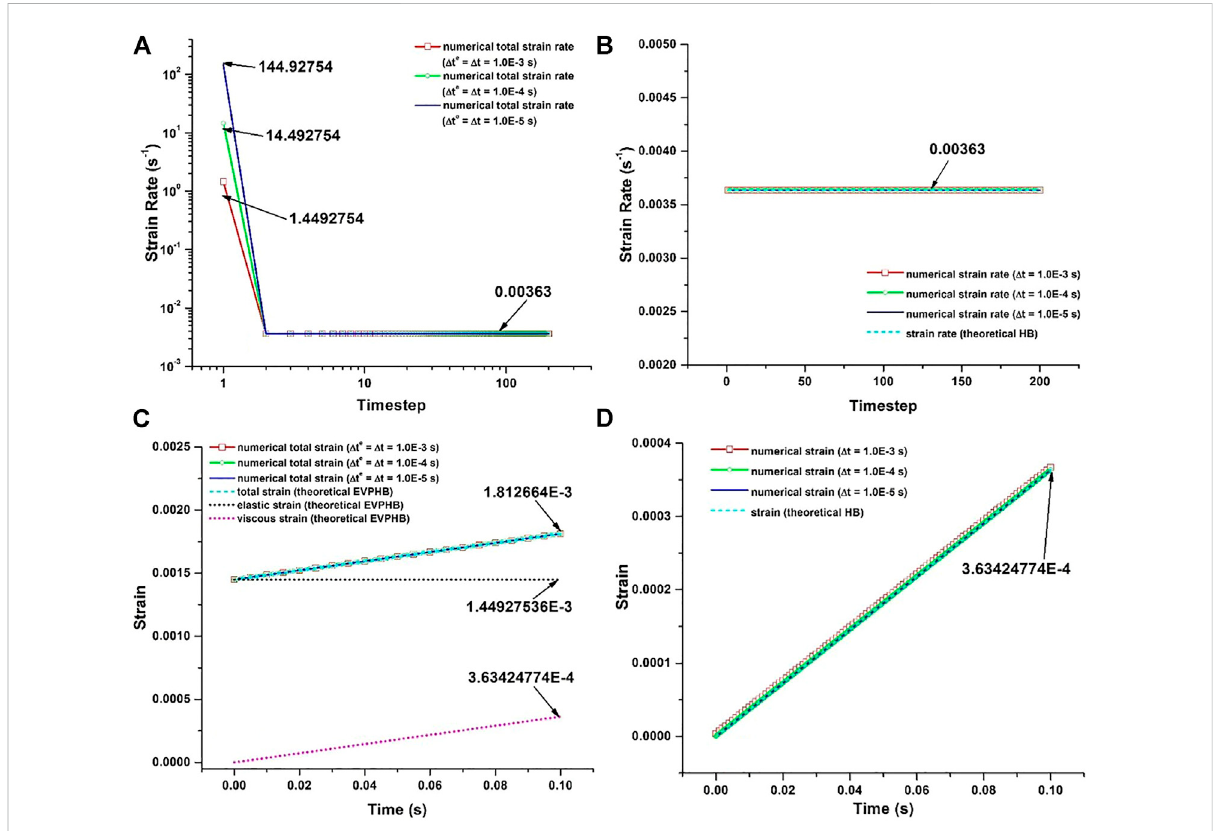
Shearstresslargerthanyieldstress.ThetotalshearstrainrateandstrainproducedbyEVPHBmodelwereseparatelyplottedin (A) and (C) ,shear strain rate and strain produced by RHB model were separately plotted in (B) and (D)